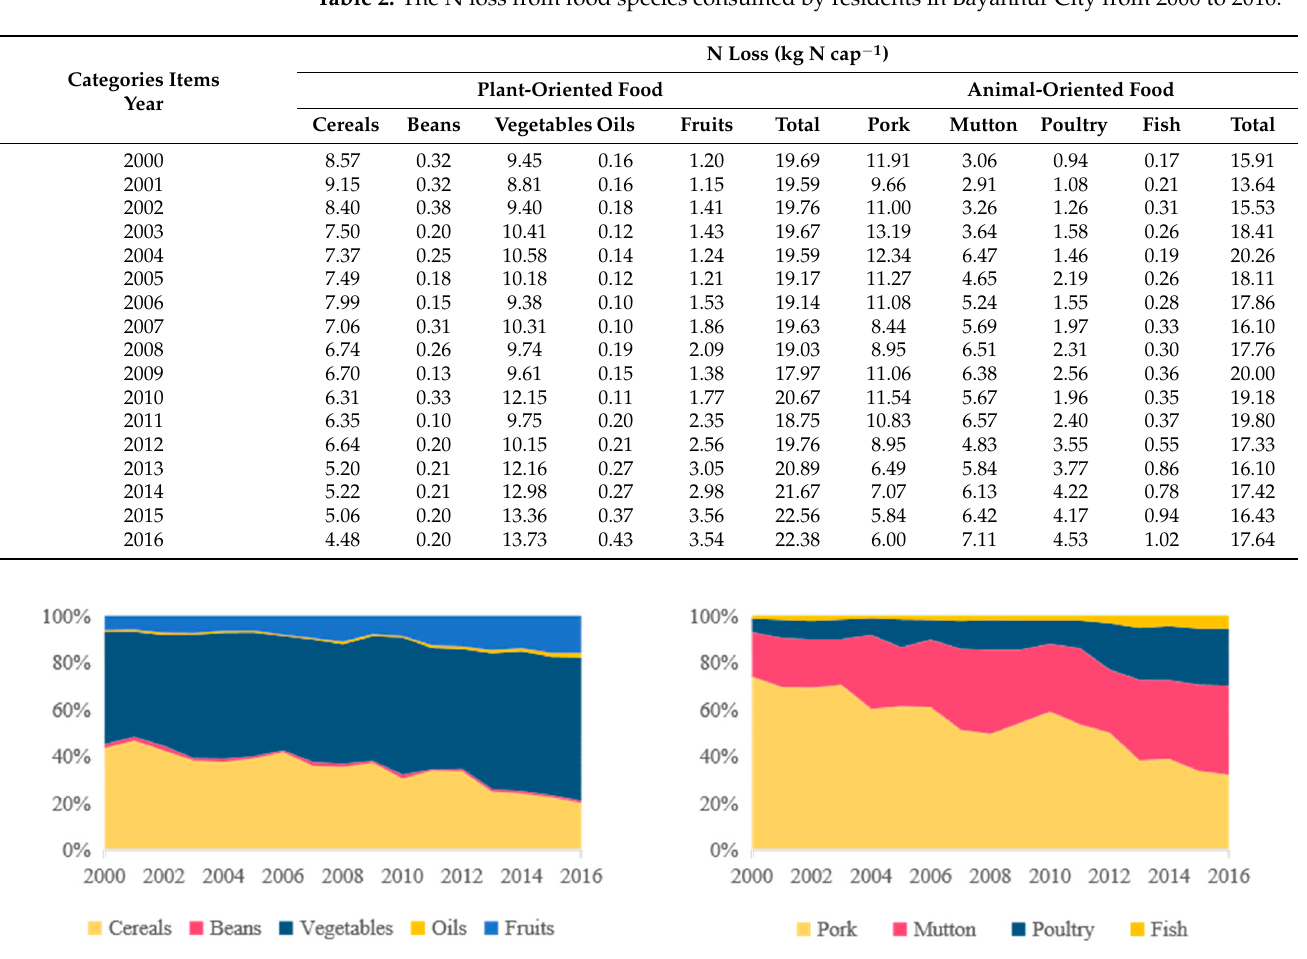
Table 2. The N loss from food species consumed by residents in Bayannur City from 2000 to 2016.